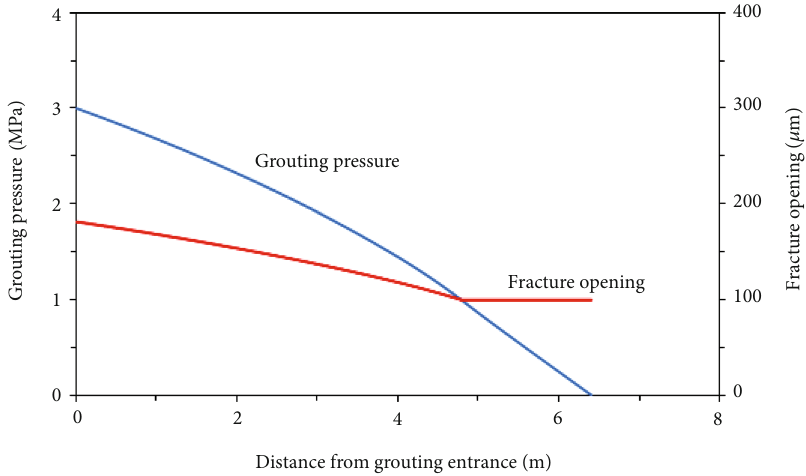
Figure 7: The curve of grouting pressure and fracture opening with fl uid-solid coupling.